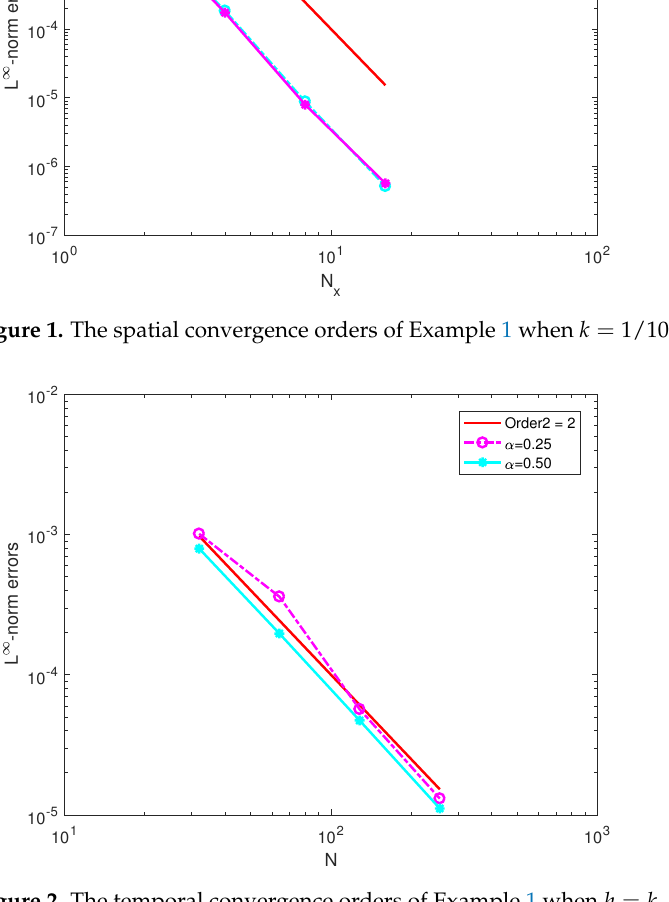
Figure 2. The temporal convergence orders of Example 1 when h = k